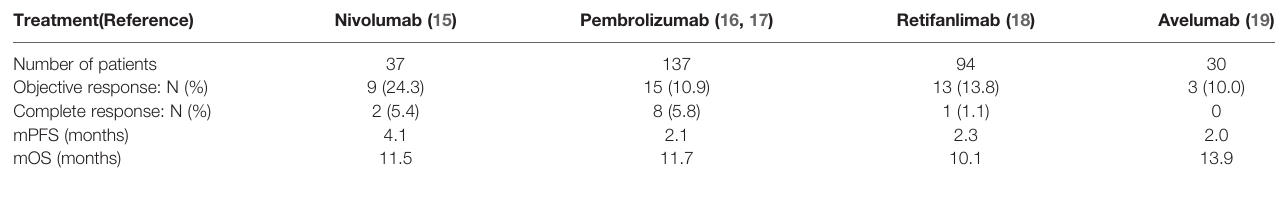
TABLE 1 | PD1/L-1 treatment in patients with refractory-advanced squamous cell carcinoma of the anus.